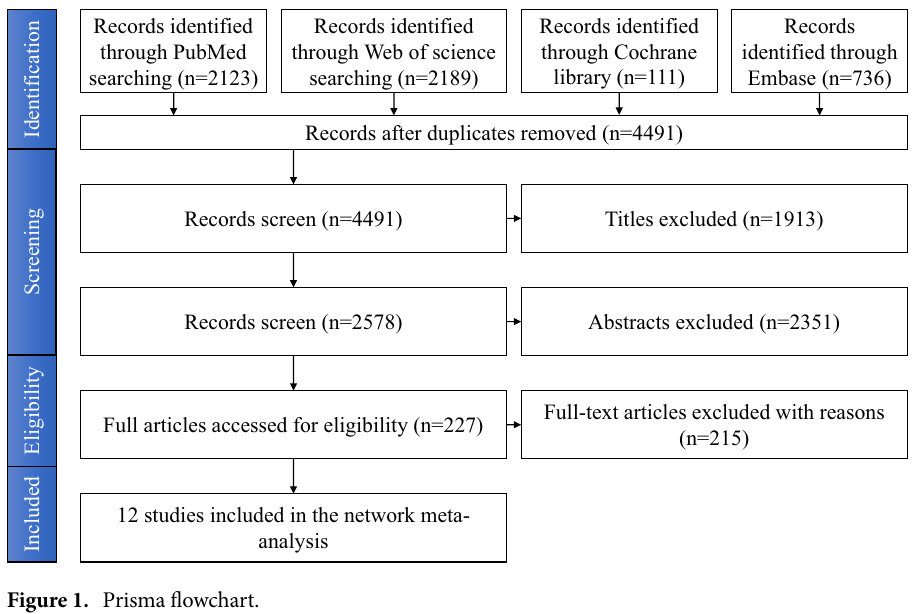
Figure 1. Prisma